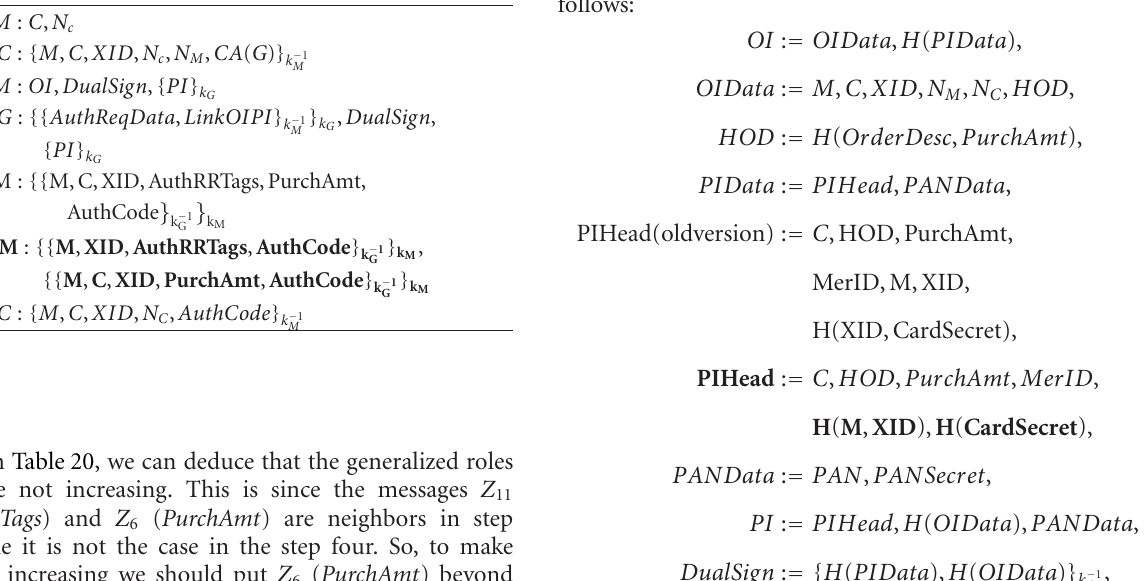
Table 21: A Secure version of the SET